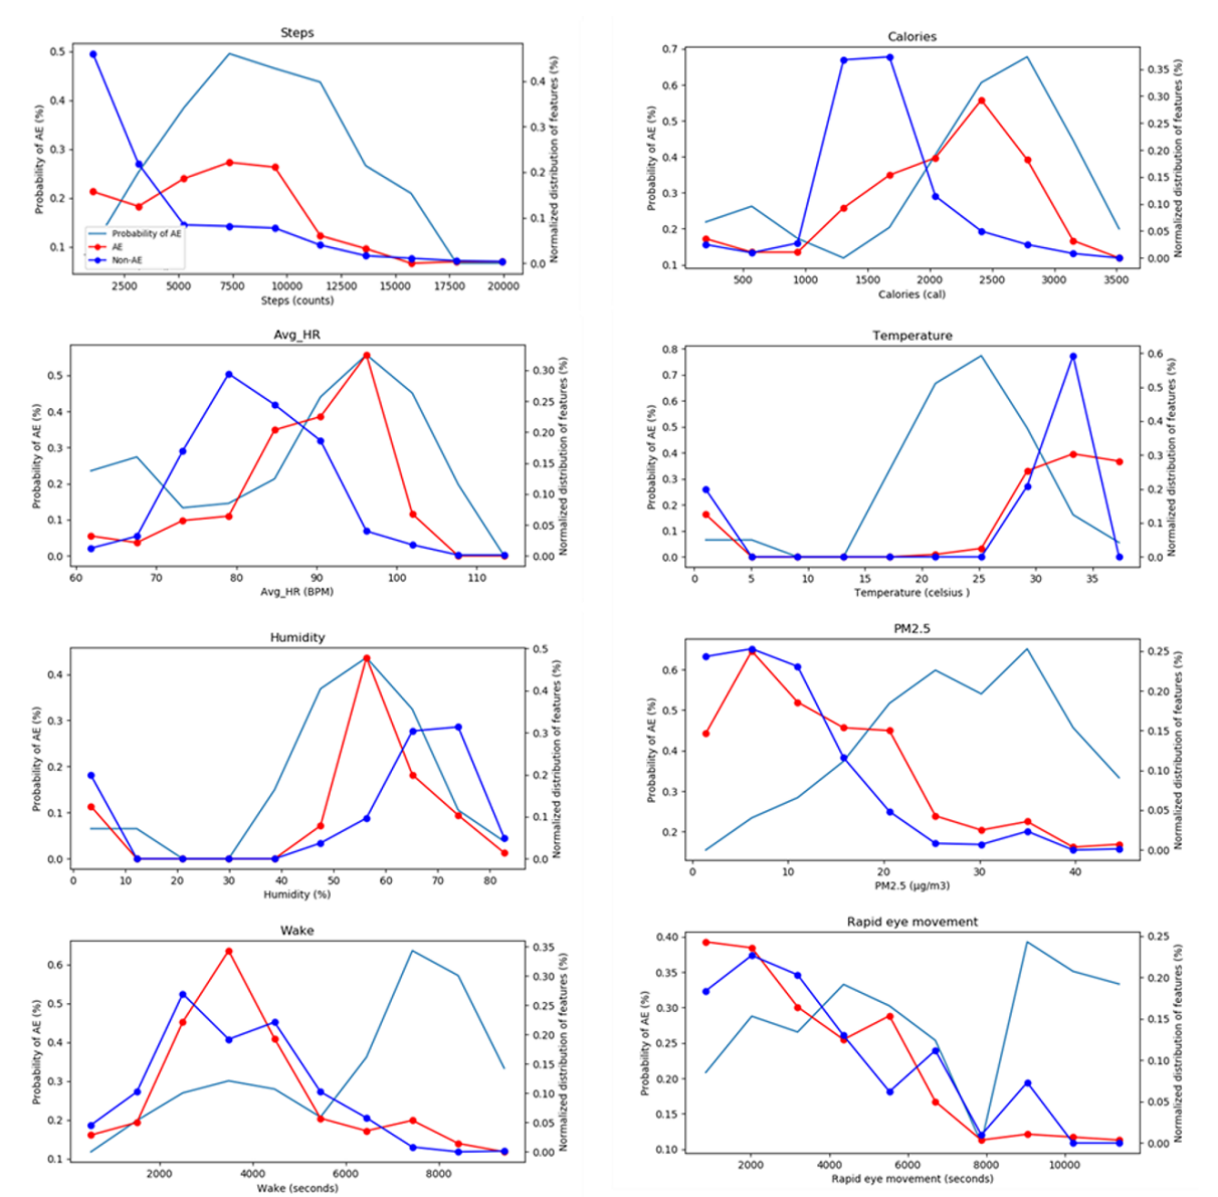
Figure 11. Acute exacerbation of chronic obstructive pulmonary disorder probability trends versus normalized distributions of physiological and